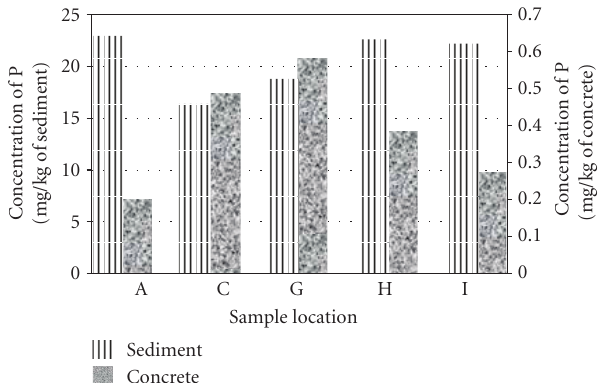
Figure 8: Concentration of phosphorus adsorbed to sediments within pores (primary y -axis) and to the concrete (secondary y -